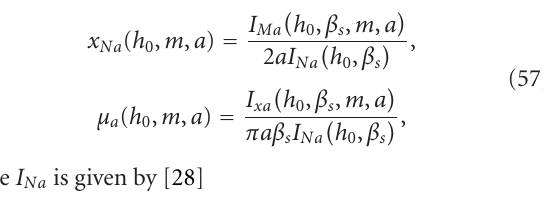
E x ( h 0 , β s ) over h 0 = 1 to 4 and β s = 100 to 2000 for m = 2 × 10 − 5 and a = 150000.